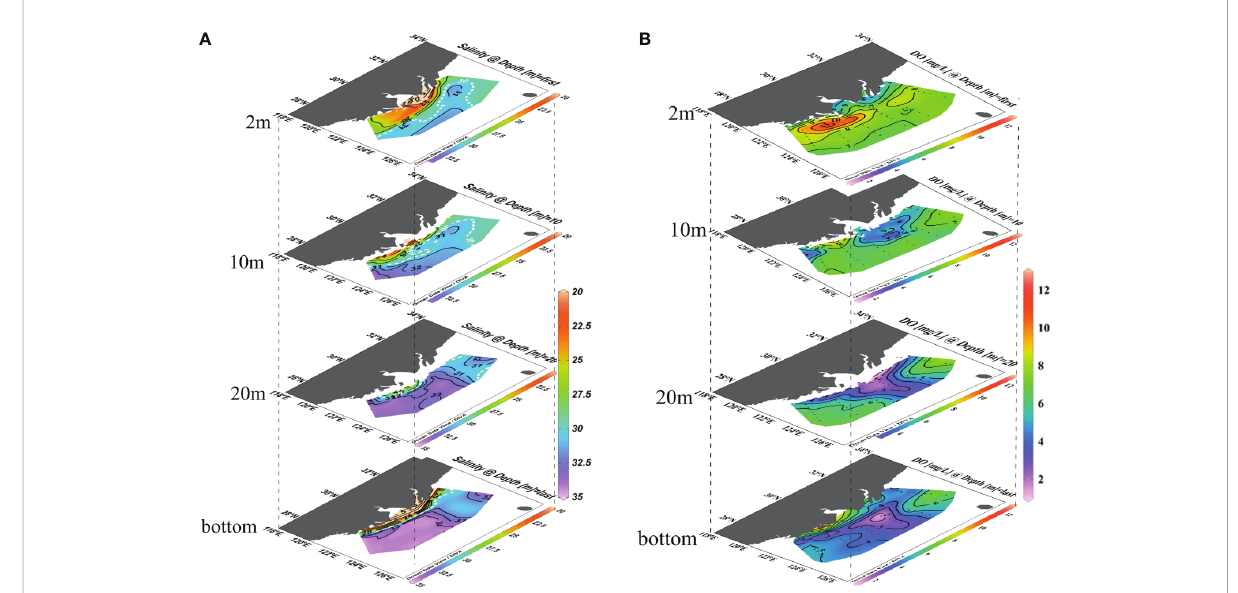
FIGURE 2 Salinity and DO spatial distributions in the water column (depth of 2 m, 10 m, 20 m, and bottom). (A) Salinity distribution. (B) Dissolved oxygen distribution map (unit: mg L − 1 ). The distributions of salinity and DO at the bottom layer cover the regions with varying depths and intersect with the upper layers at nearshore